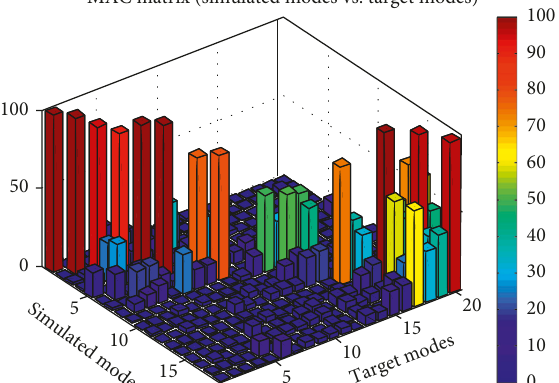
Table 17: Fuel configurations for configuration 1.